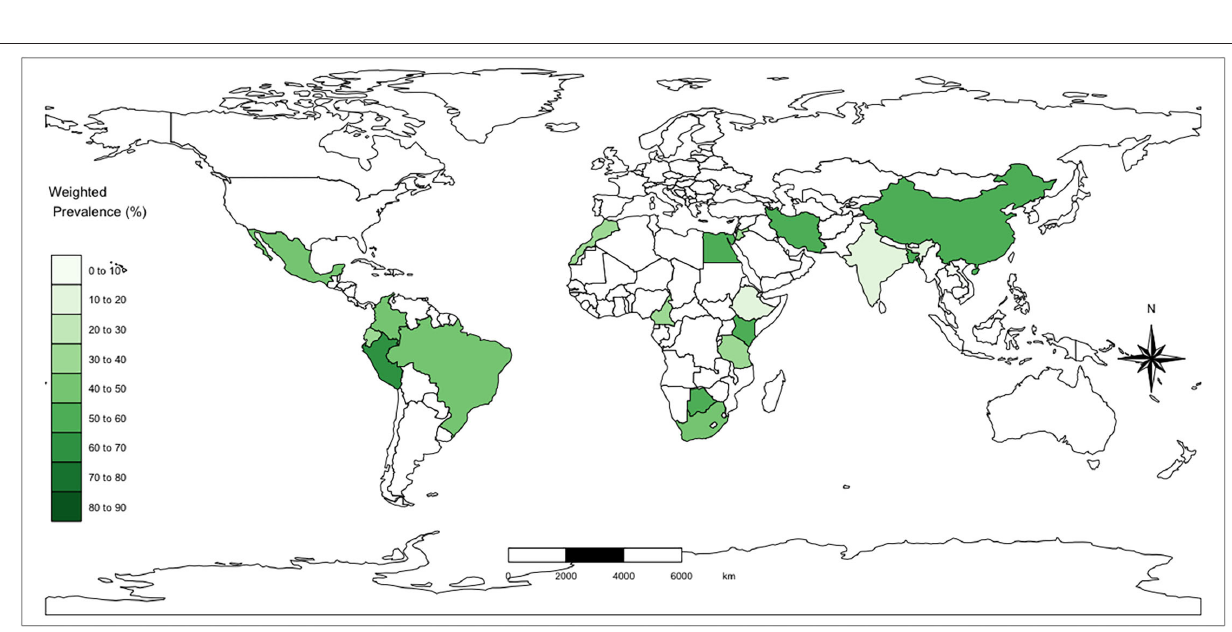
FIGURE 4 | Choropleth map showing weighted mean reported seroprevalence by country. The regions included in this review were Africa, Asia, Middle East, and South/Central America.